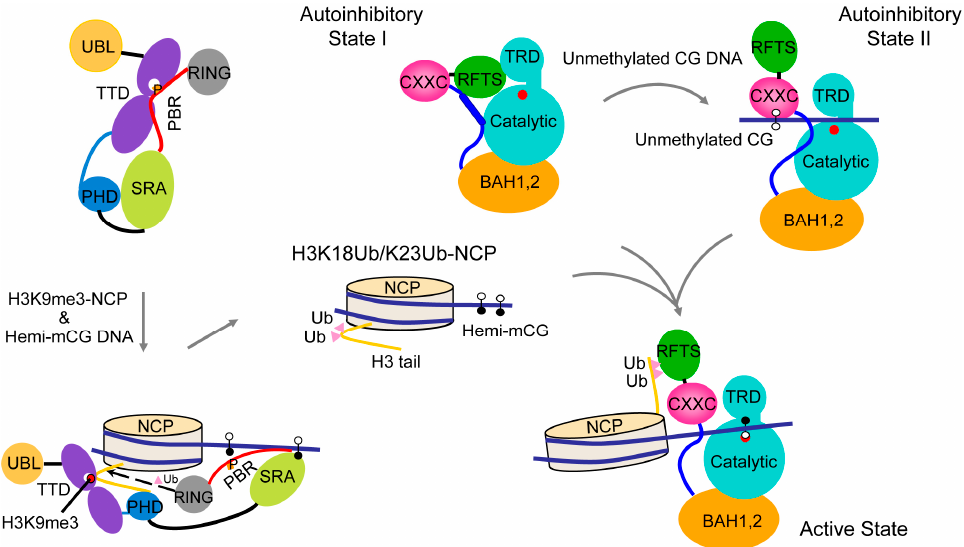
Figure 5. A model for the allosteric regulation of DNMT1-mediated maintenance DNA methylation. Hemimethylated DNA and histone H3K9me3 serve as epigenetic signals to promote UHRF1-mediated ubiquitination of histone H3, which in turn shifts the conformation of DNMT1 from the autoinhibitory state into an active state for maintenance DNA methylation. UHRF1 P656, which occupies the H3K9me3-binding cage of the tandem Tudor domain (TTD) in the closed UHRF1 conformation, is indicated by the letter P. The active site of DNMT1 is marked by a filled red circle.